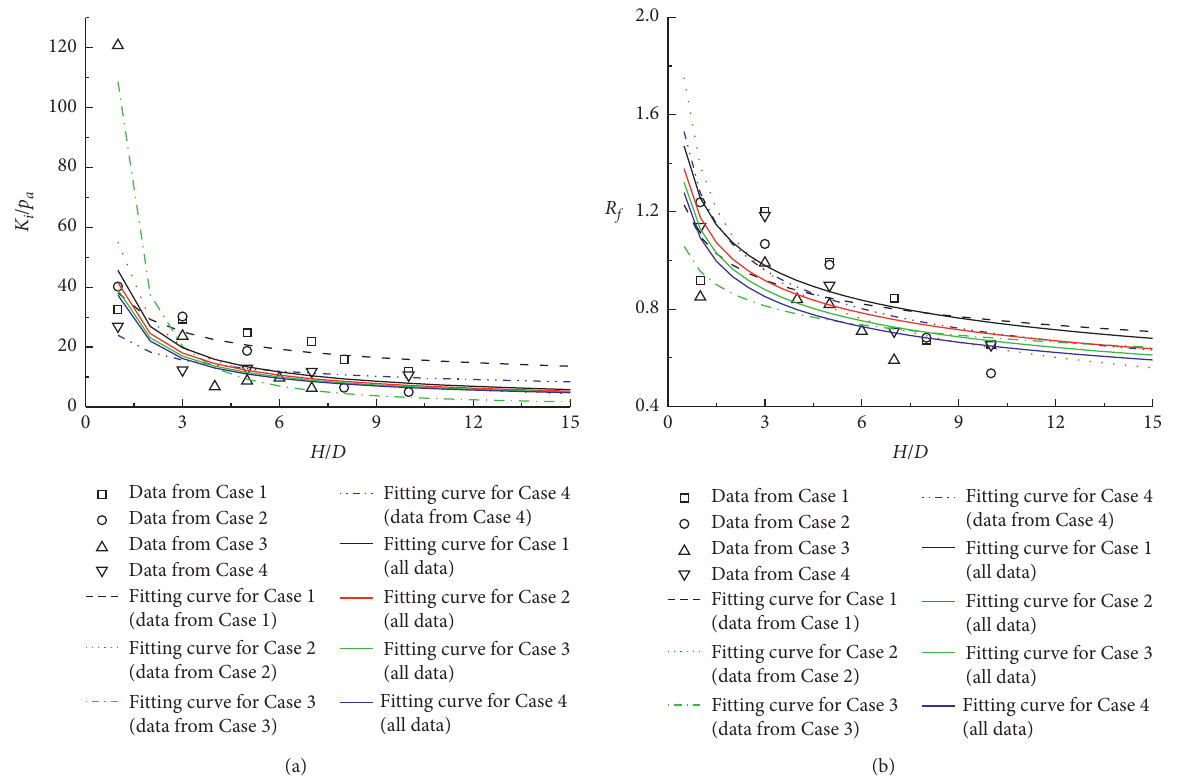
Figure 18: Fitting curve of K i and R f . (a) K i versus H/D . (b) R f versus H/D